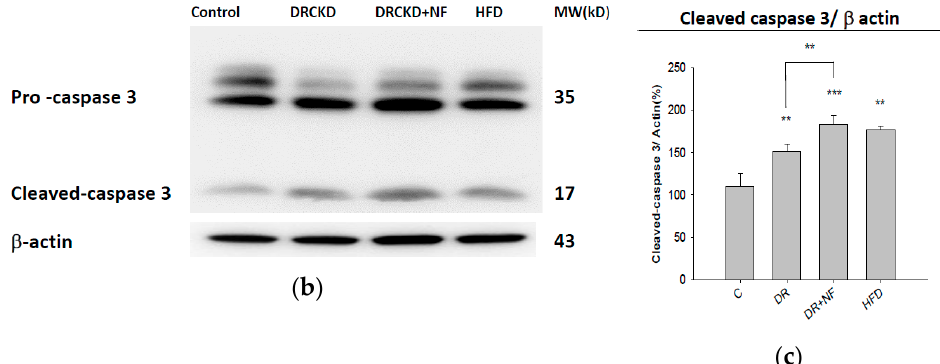
Figure 6. ( a ) Representative image and quantification for TUNEL staining of rat kidney tissues from the control, doxorubicin and chronic kidney disease (DRCKD), DRCKD + nifedipine (NF), and high-fat diet (HFD) groups. ( b ) Representative Western blot of pro-caspase 3 (35 kDa) and cleaved caspase 3 (17 kDa) of kidney tissues in rats as indicated. ( c ) Quantification of protein expression of cleaved caspase-3. β -actin was used as a constitutive protein control. Values are variations in percentage expressions relative to β -actin. ** P < 0.05, *** P < 0.01 compared to the normal control, ## P < 0.05, ### P < 0.01 compared to the DRCKD group ( n = 3).